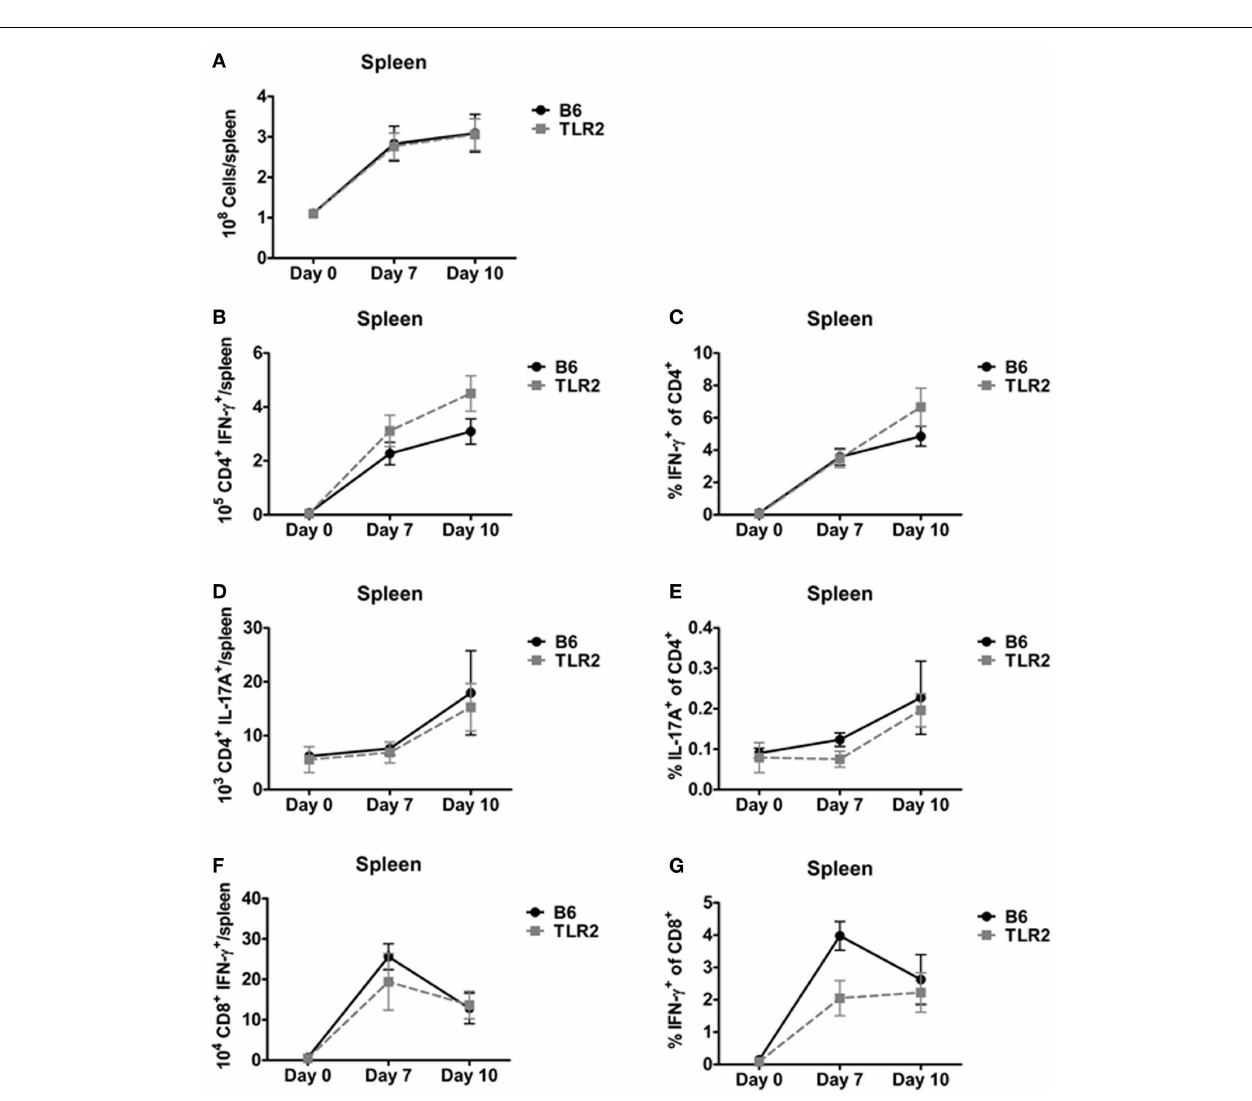
culture. Flow cytometry was used to determine the (B) total number of CD4 + IFN- γ + T-cells, (C) % IFN- γ + of CD4 + T-cells, (D) total number of CD4 + IL-17A + T-cells, (E) % IL-17A + of CD4 + T-cells, (F) total number of CD8 + IFN- γ + T-cells, and (G) % IFN- γ + of CD8 + T-cells. Data are combined from at least two independent experiments per time point. n = 4–6 mice/group. Statistical significance was determined using a Mann–Whitney test for each time